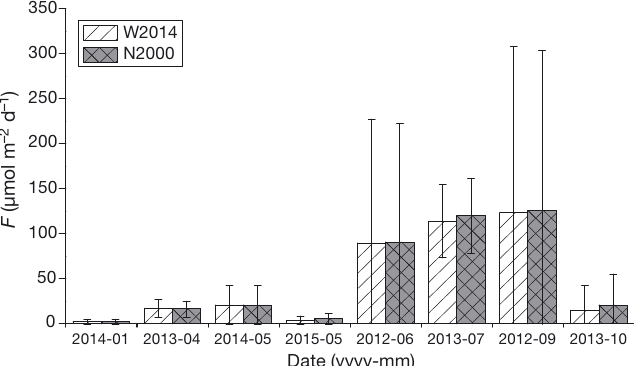
Fig. 8. Seasonal variation of air−sea CH 4 fluxes ( F , µmol m −2 d −1 ; mean ± SD) in Sanggou Bay, estimated using 2 different equations (W2014 and N2000); see ‘Materials and methods’ for